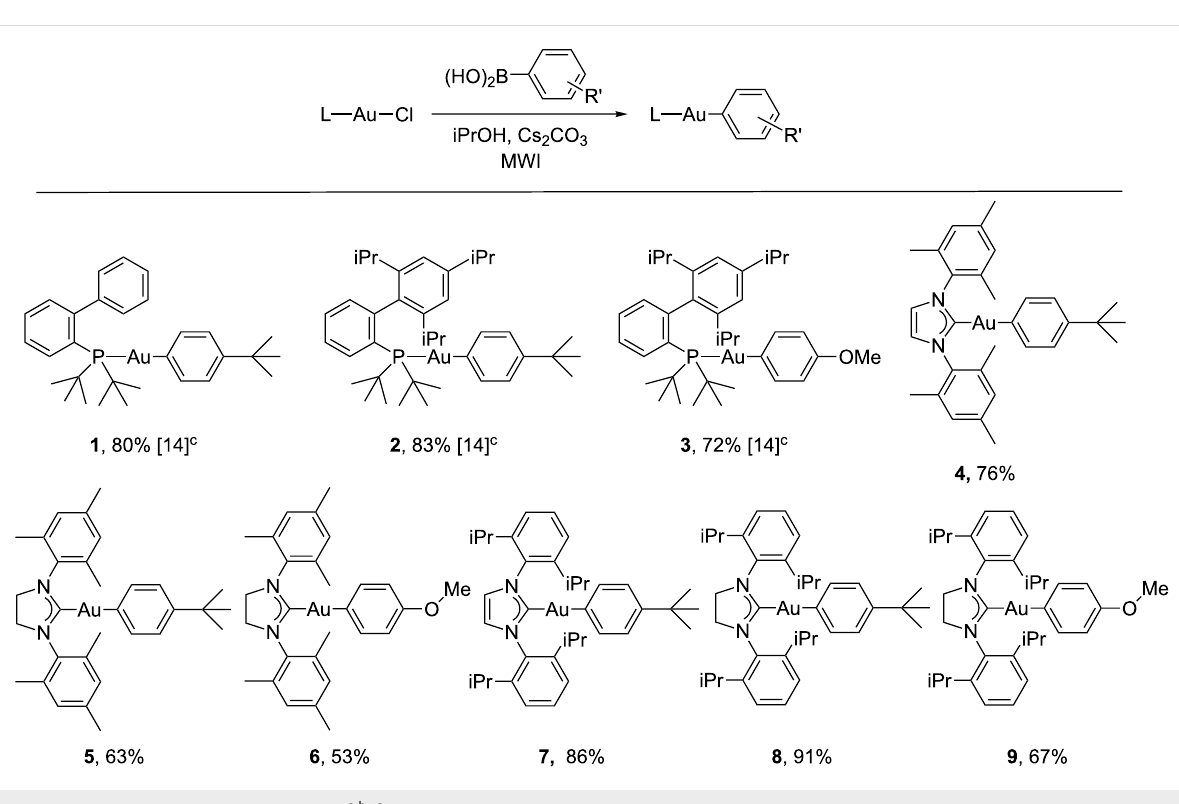
Figure 1: Synthesis of arylgold compounds a,b . a Chlorogold precursor (0.32–0.37 mmol), 2 equiv arylboronic acid, 2 equiv Cs 2 CO 3 , 50 °C, 20 min, iPrOH (1.5 mL), microwave irradiation. b Isolated yields. c THF was used as the solvent.